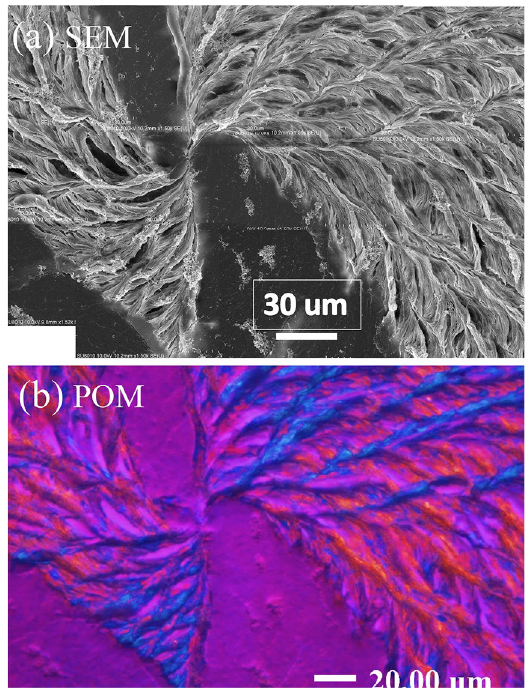
Figure 11. Top-surface topography of dual-fan sector-face PLLA spherulites crystallized from PLLA/PMMA (80/20) blend at 115 °C after solvent-etching: ( a ) SEM, and ( b ) POM micrograph (flipped to mirror image), showing lamellae in two opposite directions of nucleus center.